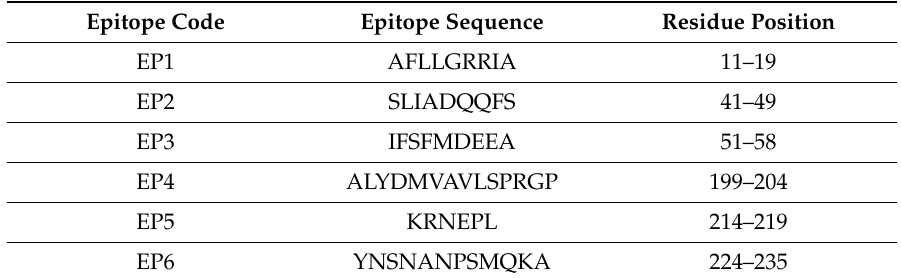
Figure 1. Spot synthesis analysis for linear B-cell epitopes in T. cruzi PS-like protein. A library of 14-mer peptides that sequentially represents the coding sequence of T. cruzi PS-like protein with a 9 amino acid overlap was synthesized directly onto a cellulose membrane followed by probing with a pool of Chagasic patient sera ( n = 8). ( A ) Image of the chemiluminescent signal from bound human IgG antibodies. Peptides containing epitope sequences are identified by boxes. ( B ) Graph of the signal intensities normalized to the maximum and minimum signals from the positive and negative controls, respectively. Epitopes were identified within consecutive peptides with intensity levels above 50%. ( C ) Table of the individual 14-mer peptides and their locations on the membrane. Table 1. Epitopes mapped in Trypanosoma cruzi PS-like protein (Q4CMV5) using a pool of sera from patients with chronic Chagas disease.